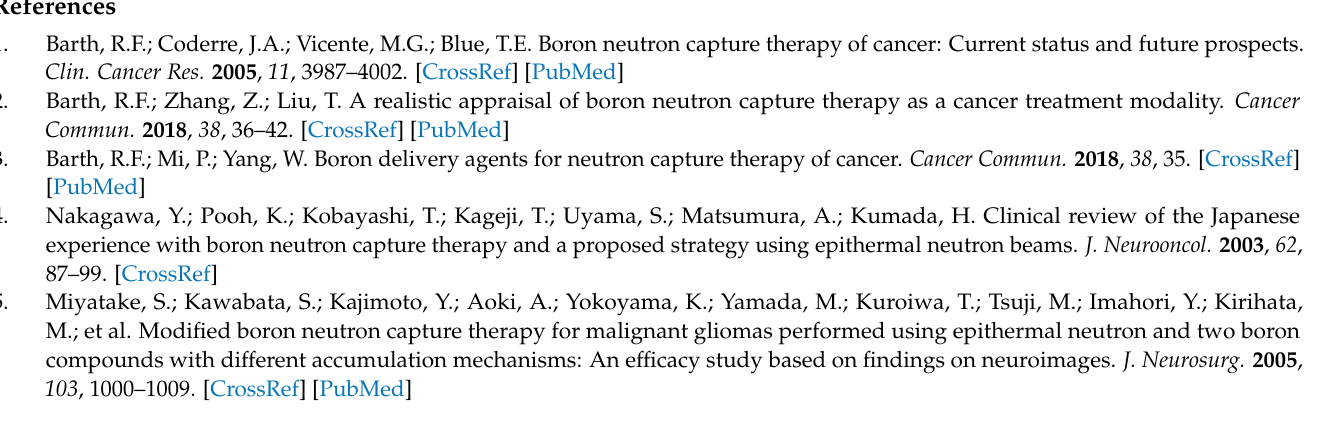
Figure S4. Scheme S1—Synthesis of maleimide-functionalized closo -dodecaborate (B 12 H 11 -mal), Scheme S2—HTLTFAc